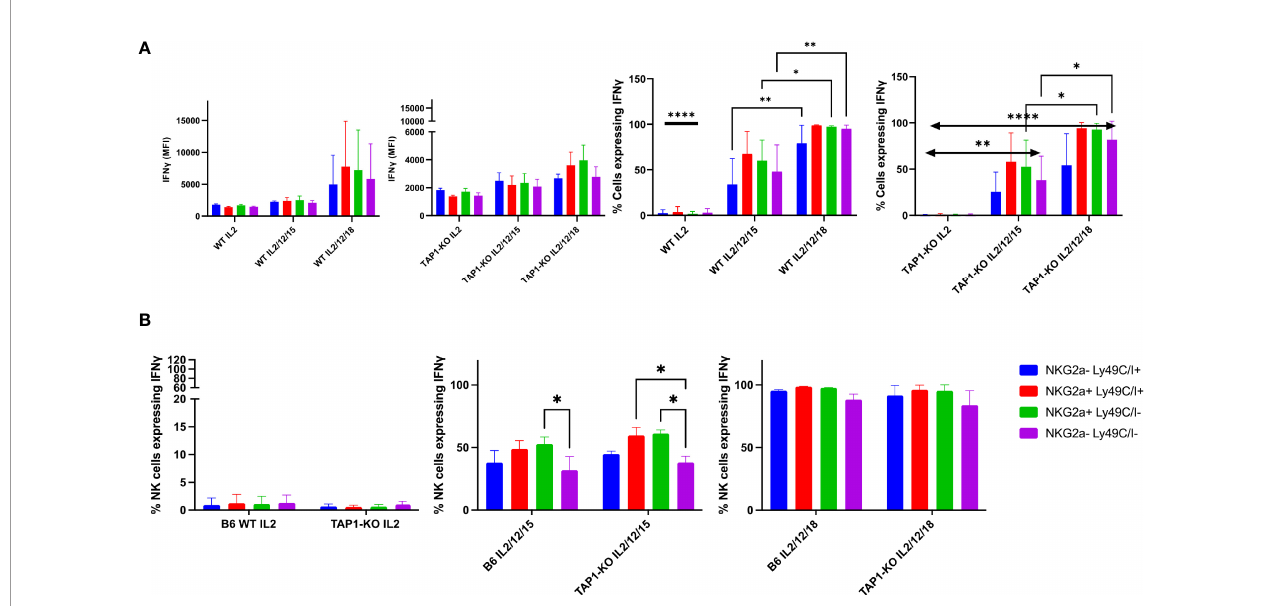
FIGURE 6 | (A) IL-2 expanded B6 WT and TAP1-KO NK cells from murine spleens were activated with overnight stimulation of cytokines IL-2, (IL-2, IL-12, IL-15) and (IL-2, IL-12, IL-18). At day 1, IFN g was measured in CD3-NK1.1+ NK cells by intracellular fl ow cytometry staining. Statistical analysis was performed using GraphPad Prism 9.0.0 with an ordinary two-way ANOVA with Sidak multiple comparisons tests (n=3). *, p<0.05, **, p<0.01 and ****, p<0.0001. (B) B6 WT and TAP1-KO NK cells from murine spleens were expanded in the presence of IL-2 for 5 days. On day 5, NK cells were activated with overnight stimulation of cytokines IL-2, (IL-2, IL-12, IL-15) and (IL-2, IL-12, IL-18). IFN g was measured in CD3-NK1.1+ NK cells by intracellular fl ow cytometry staining. Statistical analysis was performed using GraphPad Prism 9.0.0 with an ordinary two-way ANOVA with Sidak multiple comparisons tests (n=3). *, p<0.05, **, p<0.01 and ****,